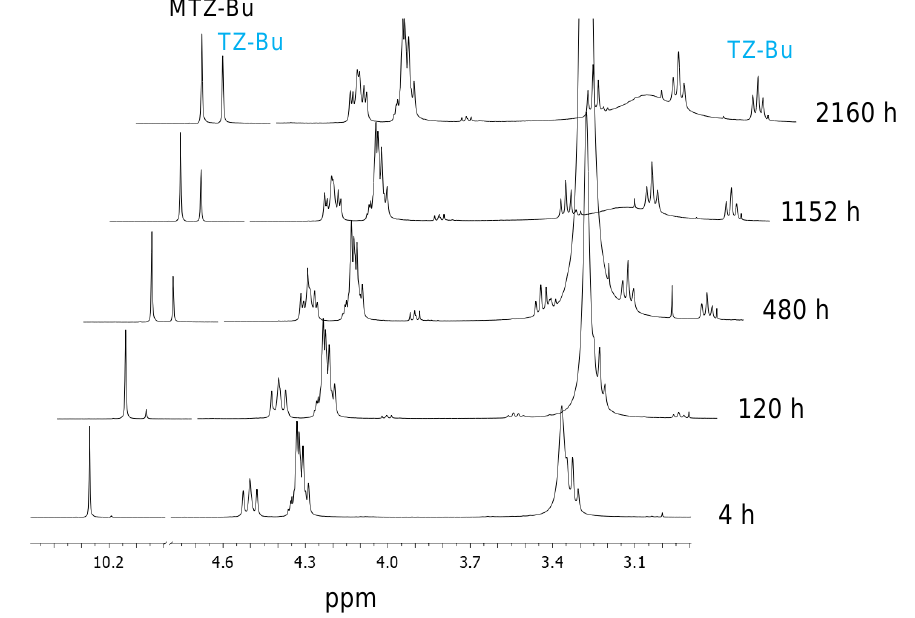
Figure 1. 1 H-NMR spectra of the MTZ-Bu at different percentages of hydrolysis.